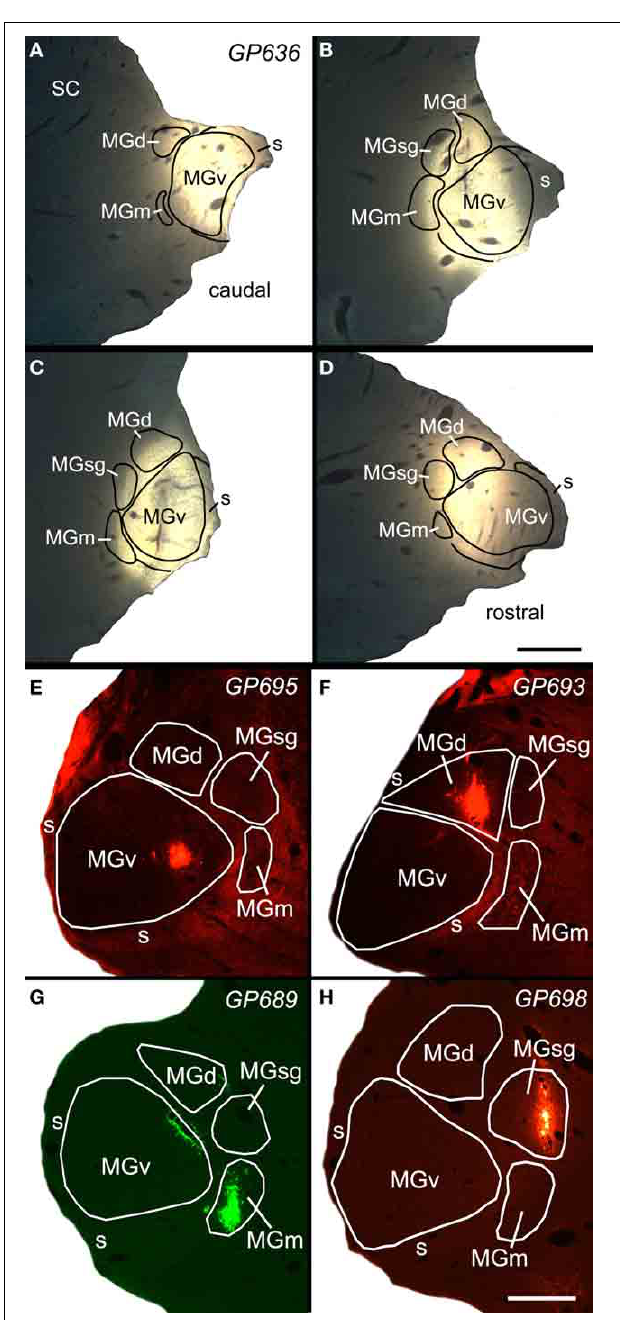
FIGURE 1 | Photomicrographs of a representative large injection site (A–D) and 4 small injection sites (E–H) in the medial geniculate nucleus (MG). (A–D) Series of transverse sections through the MG showing a large injection of FluoroGold that involved all MG subdivisions. Sections are arranged from caudal to rostral. Scale bar in D = 1mm. (E) Small injection of red beads confined to the ventral subdivision of the MG (MGv). (F) Small injection of red beads confined to the dorsal subdivision of MG (MGd). (G) Small injection of green beads into the medial subdivision of the MG (MGm). Additional green fluorescence is seen around the margins of a blood vessel along the dorsomedial border of the ventral MG (v); this represents spread of beads that does not result in retrogradely labeled cells. This injection was into the right MG; the image has been reversed left